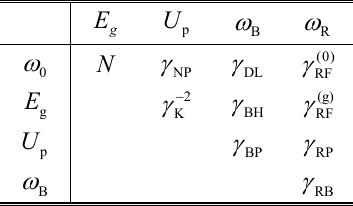
Table 1. Characteristic frequencies and dimensionless adiabaticity parameters describing the regimes (adiabatic and diabatic limits) of laser-field interaction with periodic potentials. The parameters are proportional to the ratio of the frequencies from upper row and left column.